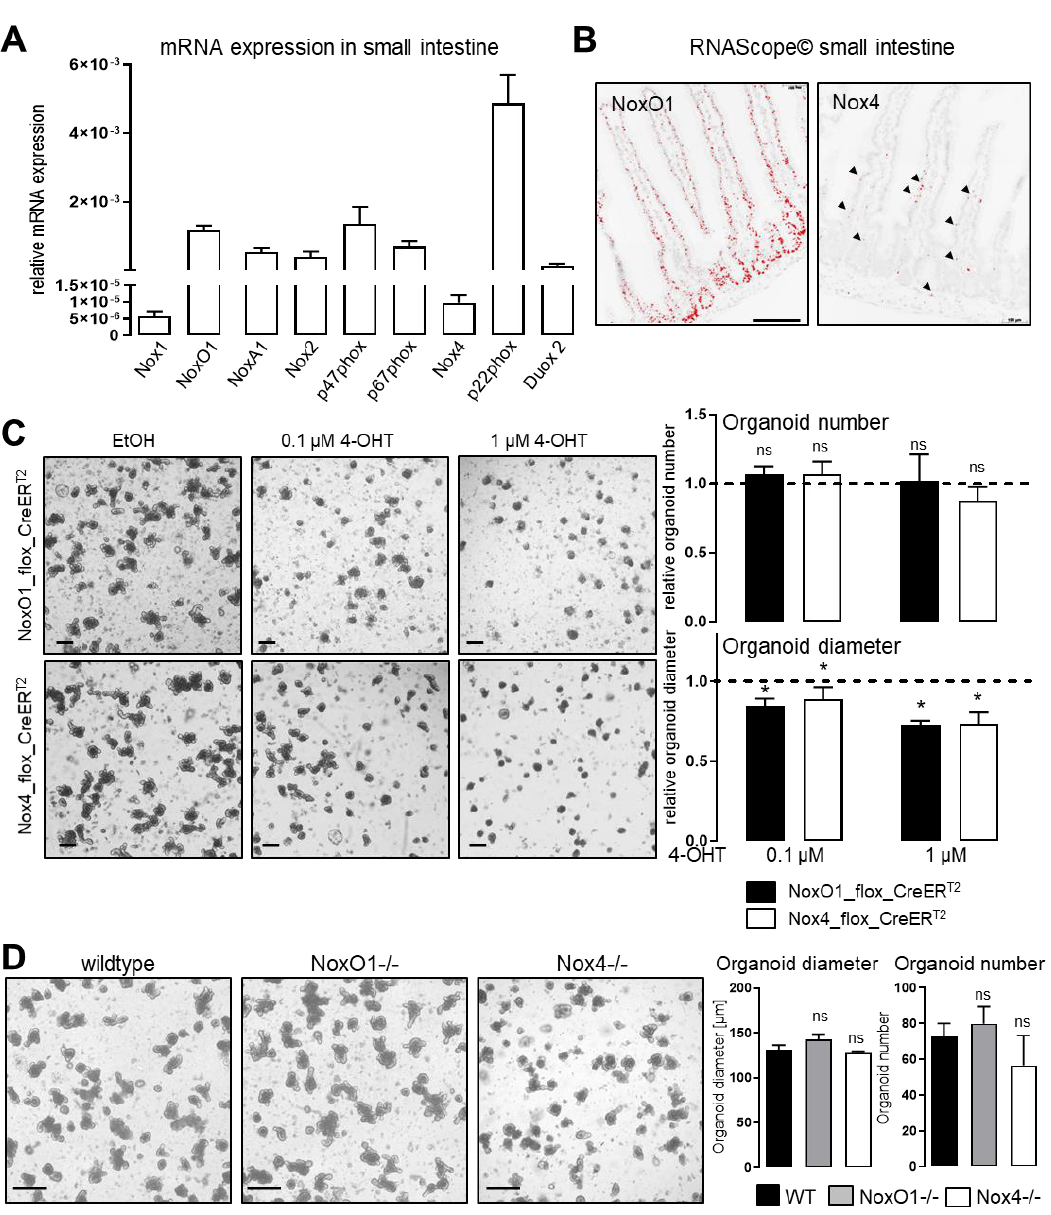
Figure 3. Cre-recombinase, but not NADPH oxidases interfere with organoids growth. ( A ) qRT- PCR for Nox subunits in small intestinal tissue. mRNA expression relative to EF2 housekeeping gene. n = 9; mean with SEM; ( B ) Detection of NoxO1 and Nox4 mRNA in small intestine by in situ hybridization. Scale bar 200 µm; ( C ) Treatment of small intestinal organoids with either Ethanol control or 0.1 or 1 µM of 4-OHT (4-Hydroxytamoxifen). Organoids derived from differently floxed CreERT2 mouse lines. Organoids were treated with 4-OHT for 48 h. Organoid number and diameter were analyzed on day 4 after isolation and normalized to EtOH treated control. Dashed lines indicate ethanol-treated controls n = 4–13; mean with SEM; ns: none significant and * p < 0.05 EtOH vs. 4- OHT (two-way Anova, Bonferroni post-test); ( D ) Small intestinal organoids from mice constitutively lacking NoxO1 or Nox4, compared to wildtype controls. ns: none significant WT vs. kockout as indicated (two-way Anova, Bonferroni post-test); n = 5–10; bars = 200 µ